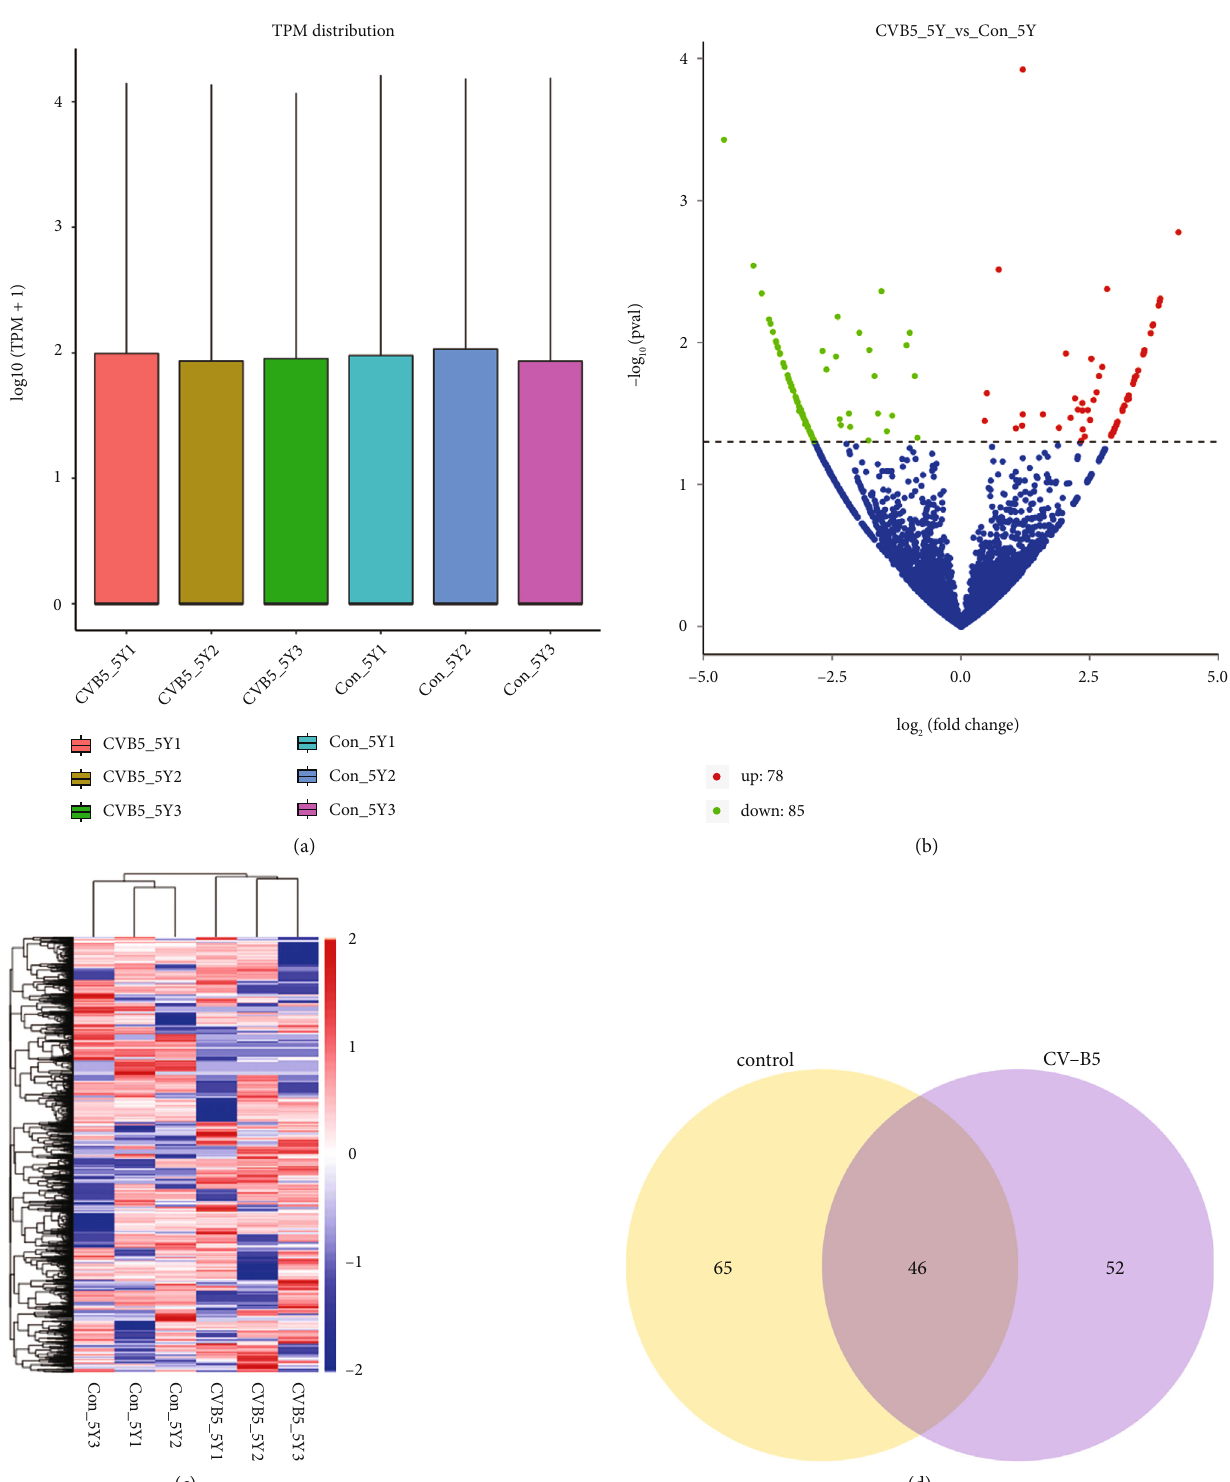
Figure 2: Di ff erentially expressed circRNAs following CVB5 infection. (a) Box plots showing the expression levels of circRNAs from each sample. (b) Volcano plots depicting di ff erentially expressed circRNAs following CVB5 infection. (c) Heatmap of maximally expressed circRNAs across all samples. (d) Venn diagrams of di ff erentially expressed circRNAs identi fi ed in mock-infected and CVB5-infected SH- SY5Y